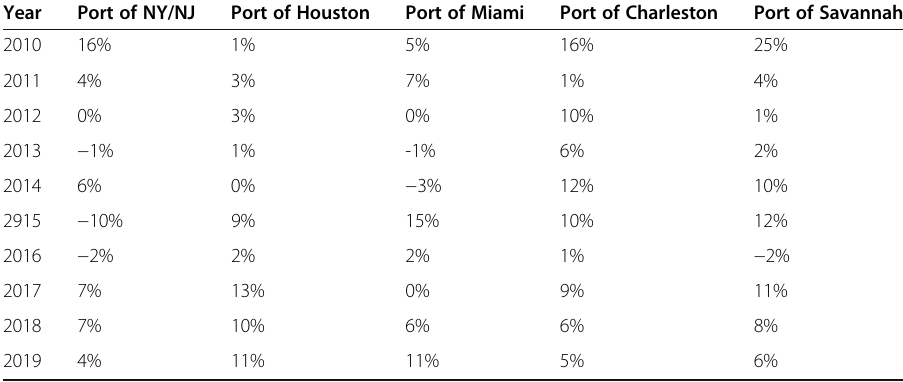
Table 1 Top 5 US East and Gulf of Mexico Ports, TEU annual Percentage Growth (%) Year